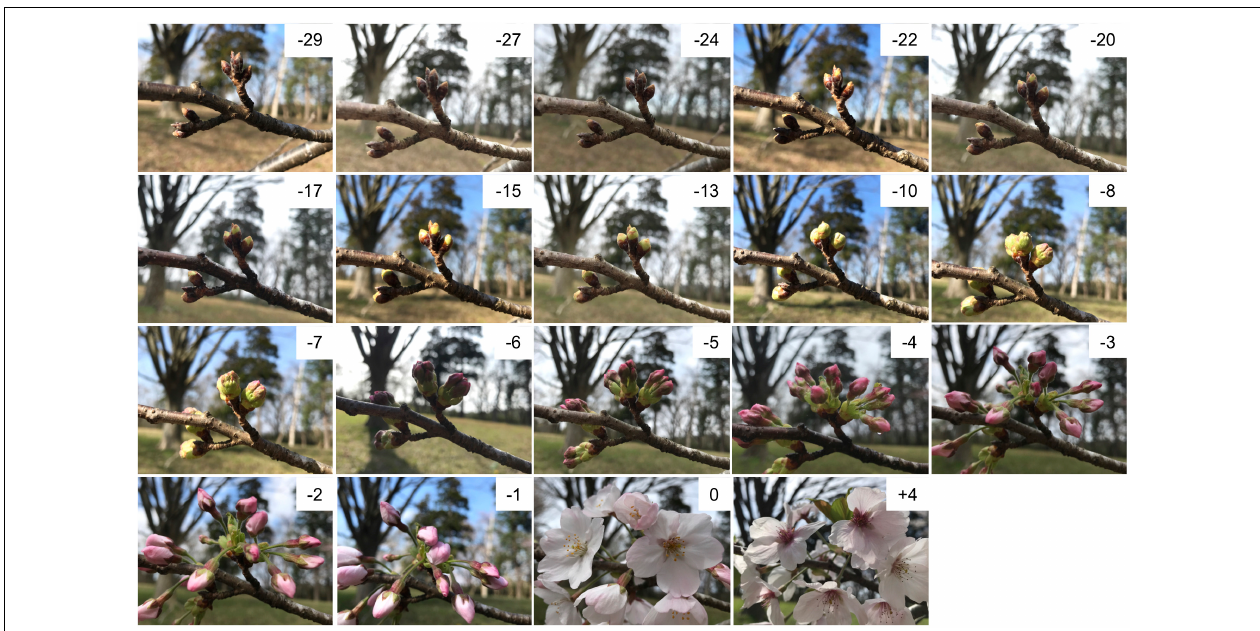
FIGURE 1 | Floral buds and open-flowers of ‘Somei-Yoshino.’ The numbers in each picture indicate days before (–) or after (+) the flowering day (0). Photos were taken at Kazusa DNA Research Institute in